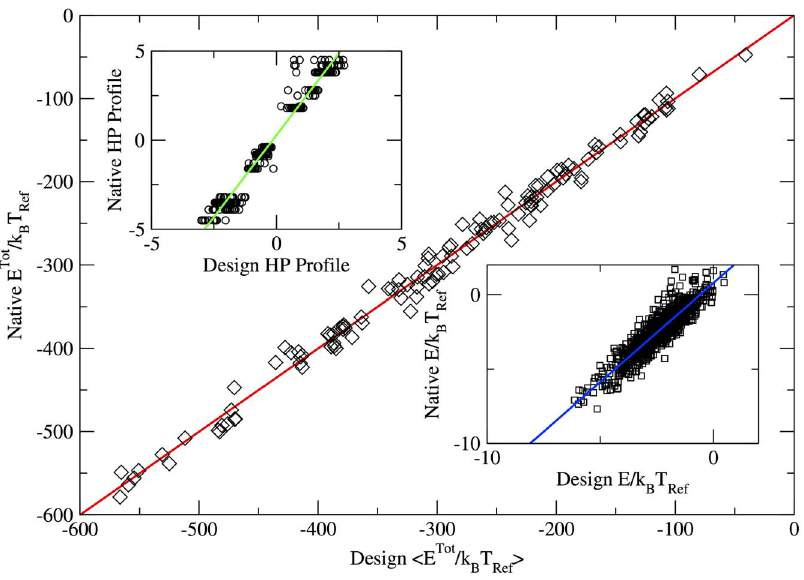
Figure 3. Comparison between the total residue energy , E Tot / k B T Ref . (Eq.S4 in SM) averaged over all the 10 5 designed sequences per target(abscissa) and the same energy calculated over the native sequence of same target (ordinate). Each point corresponds to one protein in the data set and shows a strong linear trend verified by the fit (red line) with a correlation coefficient of , 0.995 and a slope of , 1.000 indicating that two energies are perfectly correlated. In the insets we show the comparison of the HP profiles (top left) and interaction energy E = k B T Ref of each residue with all other (bottom right), this time each point corresponds to a single residue of each test protein. In both cases the data follow a remarkable linear trend (fits in green and blue lines respectively), and a positive correlation close to unity. For the HP profiles the correlation coefficient ( , 0.98) indicates that when in natural proteins we find an hydrophobic residue also the design procedure will put one and vice versa. While the correlation coefficient ( , 0.90) of E = k B T Ref demonstrates that each natural residue has a very similar contribution to the total energy compared to the designed ones. A perfect match cannot be expected since natural sequences might have experience a selection pressure influenced by interactions not represented in the model, different environmental conditions or simply unknown functional requirements. Nevertheless the accordance is